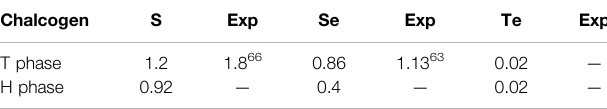
TABLE 2 | The calculated band gap (E g , eV) of monolayer HfX 2 with the T and H phases and experimental values of the bandgap in the T phase monolayer. Chalcogen